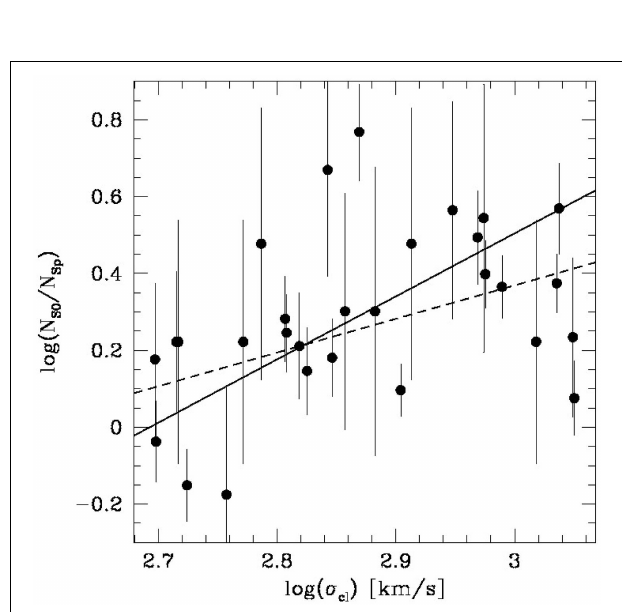
FIGURE 19 | The panel show the log of the N S 0 / N Sp fraction against the central velocity dispersion of the clusters. The solid line is the bisector least square fit, while the dashed line is the weighted least square